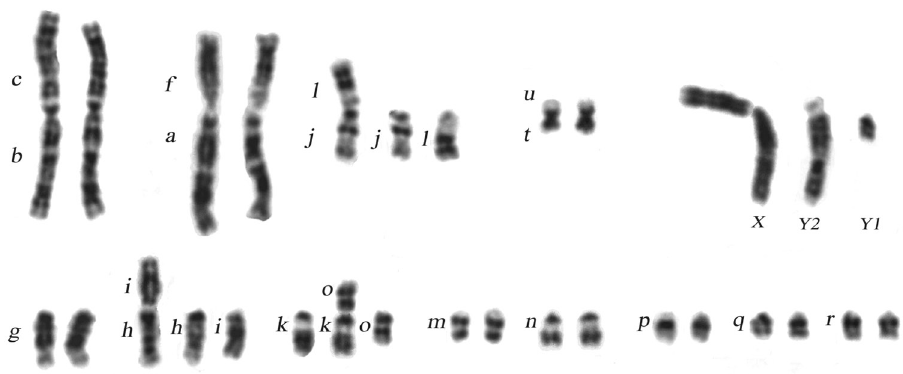
Figure 2. G-banded karyotype of male shrew of the Kiev race (Svetlogorsk vic., Belarus), g, h/i, j/l, k/o, m, n, o, p, q, r